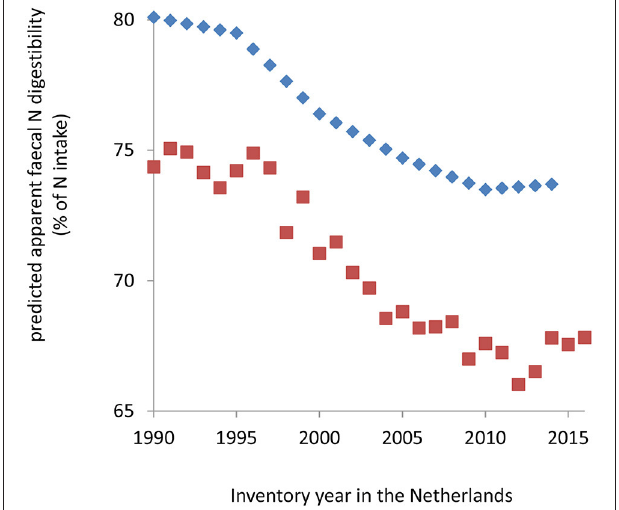
FIGURE 4 | Apparent fecal N digestibility (%) in dairy cows predicted with the CVB model (diamonds; reported values available till 2014), or predicted with the Tier 3 model (squares; activity data for calculations available till 2016), according to available activity data in the ammonia and greenhouse gas emissions inventory in the Netherlands (Velthof et al., 2012; Vonk et al.,